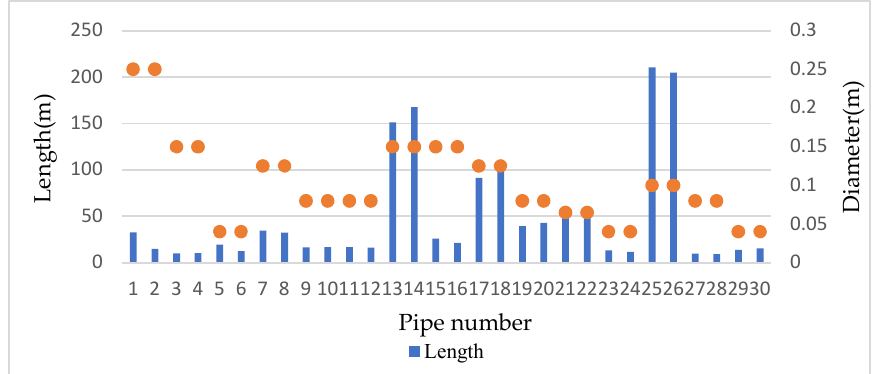
Figure 6. Basic parameters of the case pipe network.